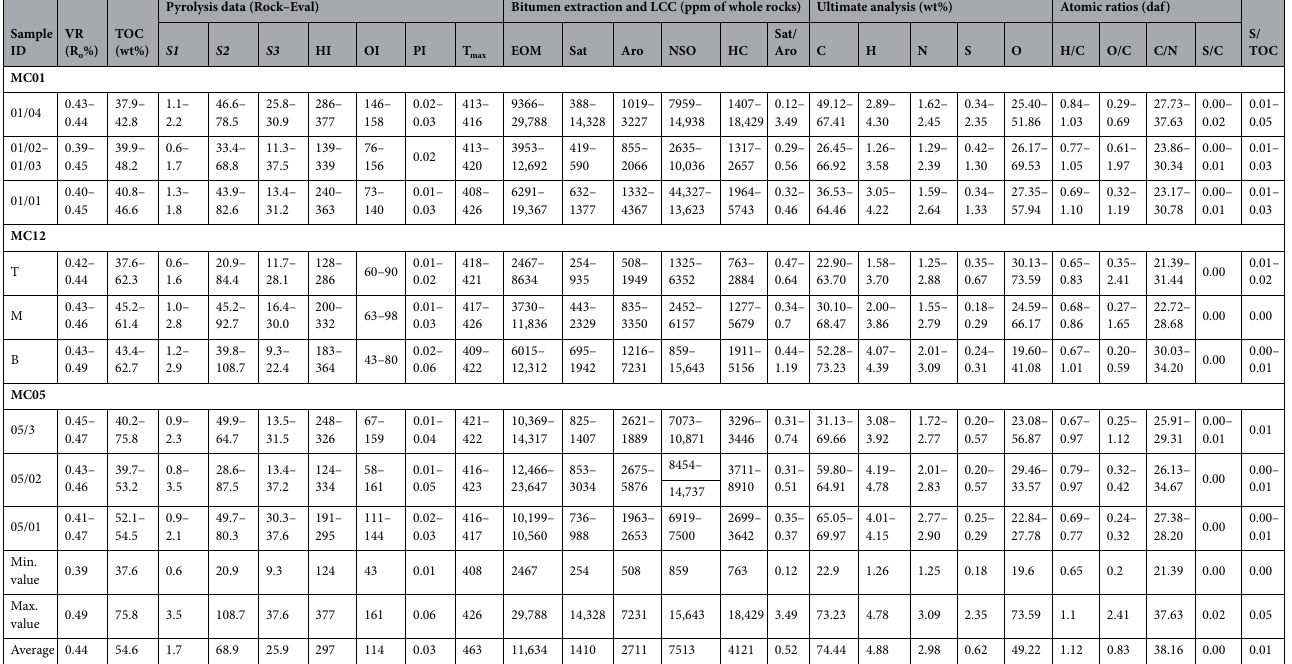
Table 2. Vitrinite reflectance, total organic carbon content (TOC), extractable organic matter (EOM), pyrolysis data, relative percentages of saturates, aromatics and nitrogen–sulphur–oxygen (NSO) compounds of EOM, ultimate analysis data and atomic ratios (dried-ash free). VR vitrinite reflectance (R o %), TOC total organic carbon content, wt%, S 1 volatile hydrocarbon (HC) content, mg HC/g rock, S 2 remaining HC generative potential, mg HC/g rock, S3 carbon dioxide yield, mg CO 2 /g rock, T max temperature at maximum of S 2 peak, HI Hydrogen Index = S 2 × 100/TOC, mg HC/g TOC, OI Oxygen Index = S 3 × 100/TOC, mg CO 2 /g TOC, PI Production Index = S 1/( S 1 + S 2), EOM extractable organic matter, Sat saturates, Aro aromatic, NSO nitrogen–sulphur–oxygen, HC